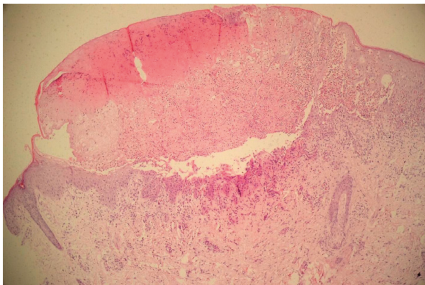
Figure 4: An ulcerative lesion with a fibrinous cap and intra- epidermal vesicles (H&E ×